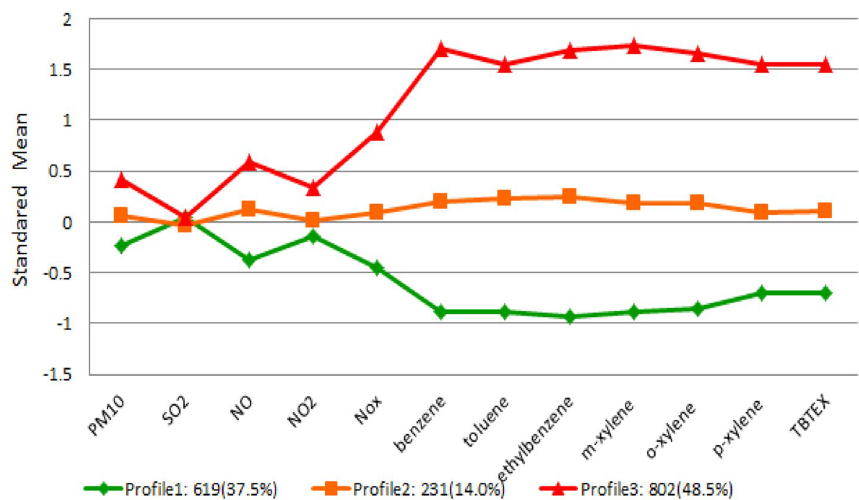
Figure 4. Standard mean values of pollutants in the three latent profiles in different areas of Tehran in